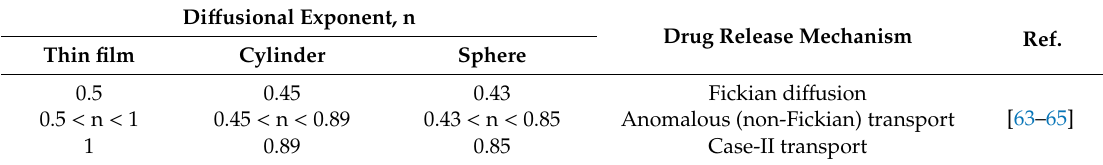
Table 4. Interpretation of di ff usional release mechanisms considering the values of di ff usional exponent n and the geometry of the delivery